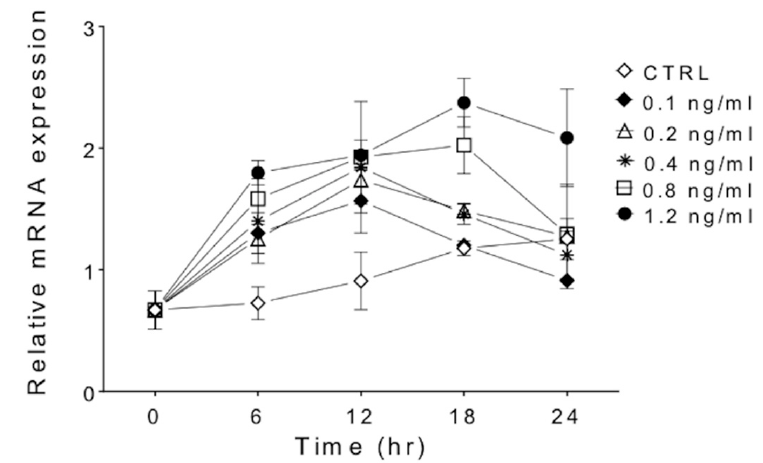
Figure 1. Quantification of sterile alpha motif and histidine aspartic domain-containing protein 1 (SAMHD1) mRNA by quantitative PCR shows a dose-dependent increase in response to increasing concentrations of IFN γ . Differences from the baseline were significant ( p < 0.05) for all concentrations of IFN γ at 6 and 12 h, and for all concentrations of IFN γ except 0.1 ng / mL at 18 h. After 24 h, SAMHD1 mRNA was significantly higher than control only in cells treated with 1.2 ng / mL of IFN γ